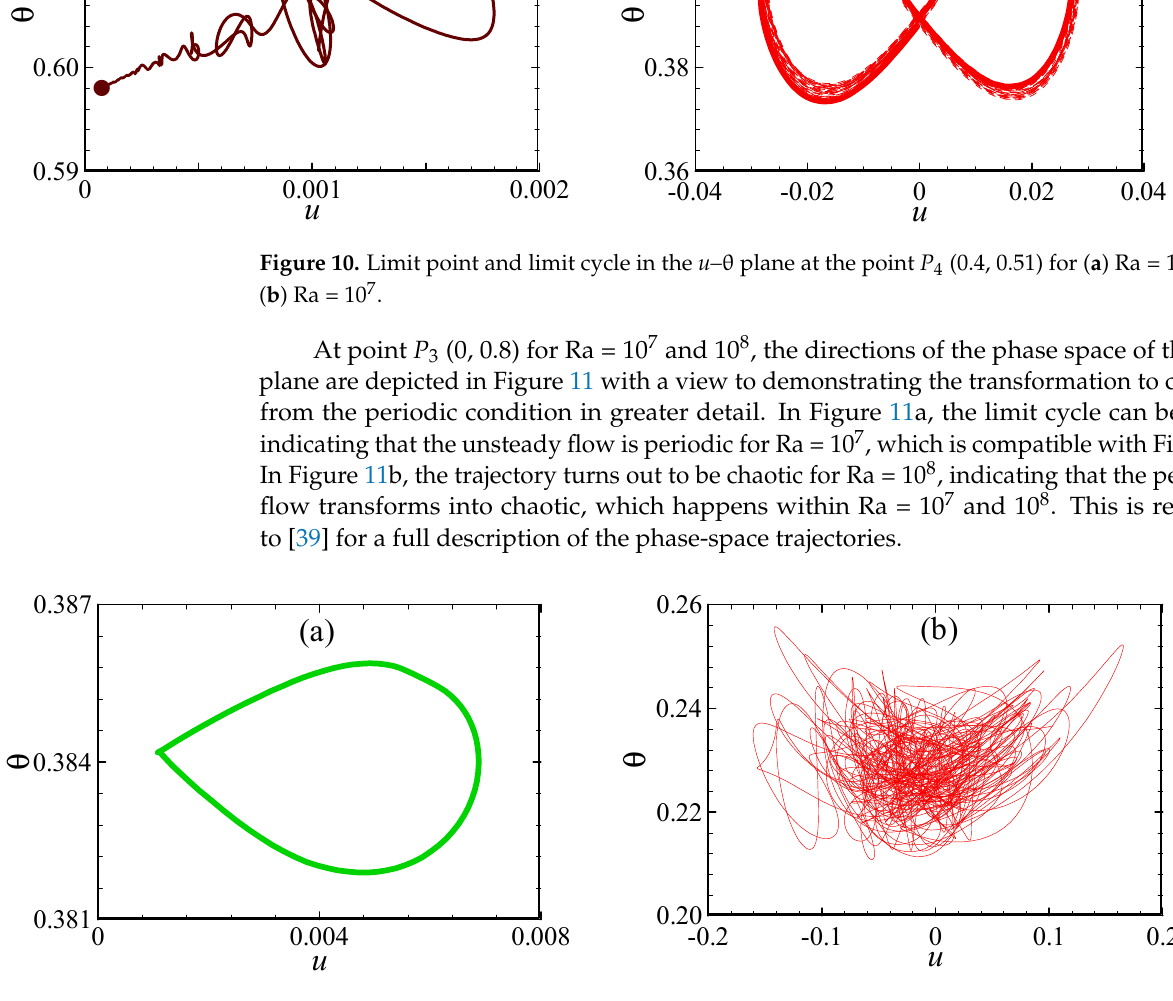
Figure 11. Phase-space trajectories in the u– θ plane at the point P 5 ( − 0.4, 0.51) for ( a ) Ra = 10 7 and ( b ) Ra = 10 8 .